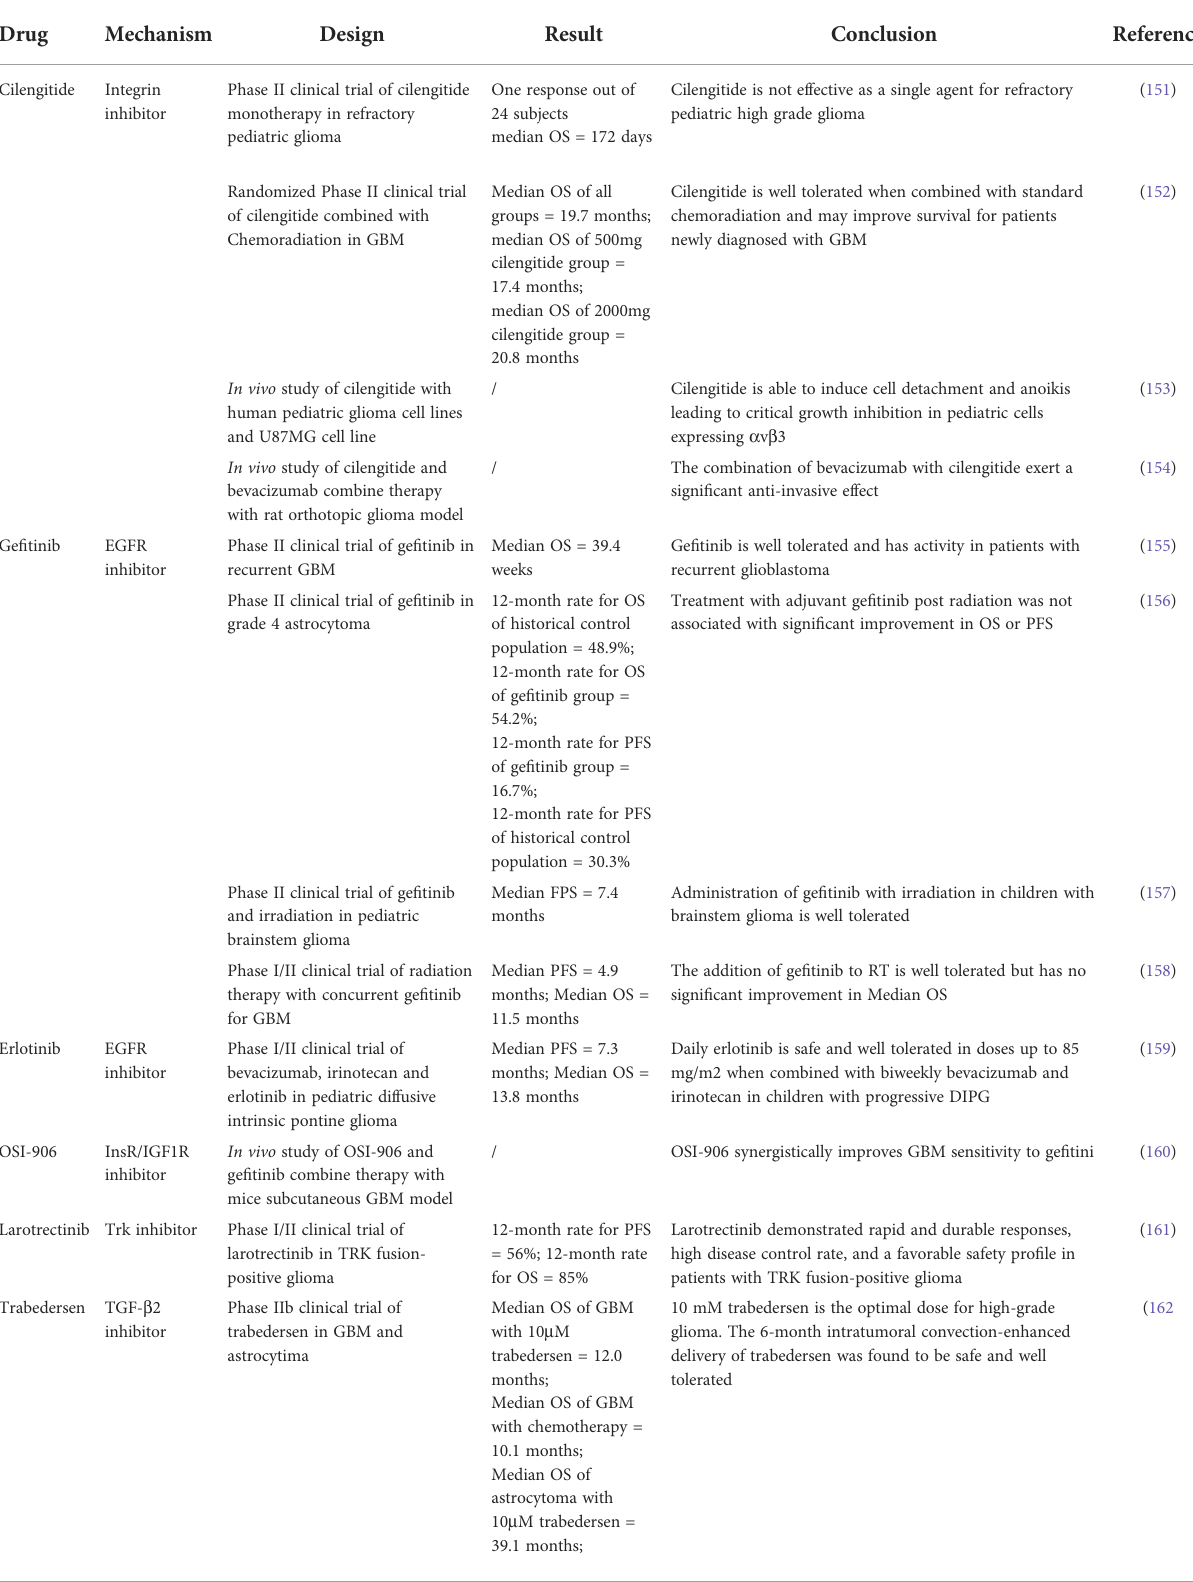
TABLE 1 Anoikis